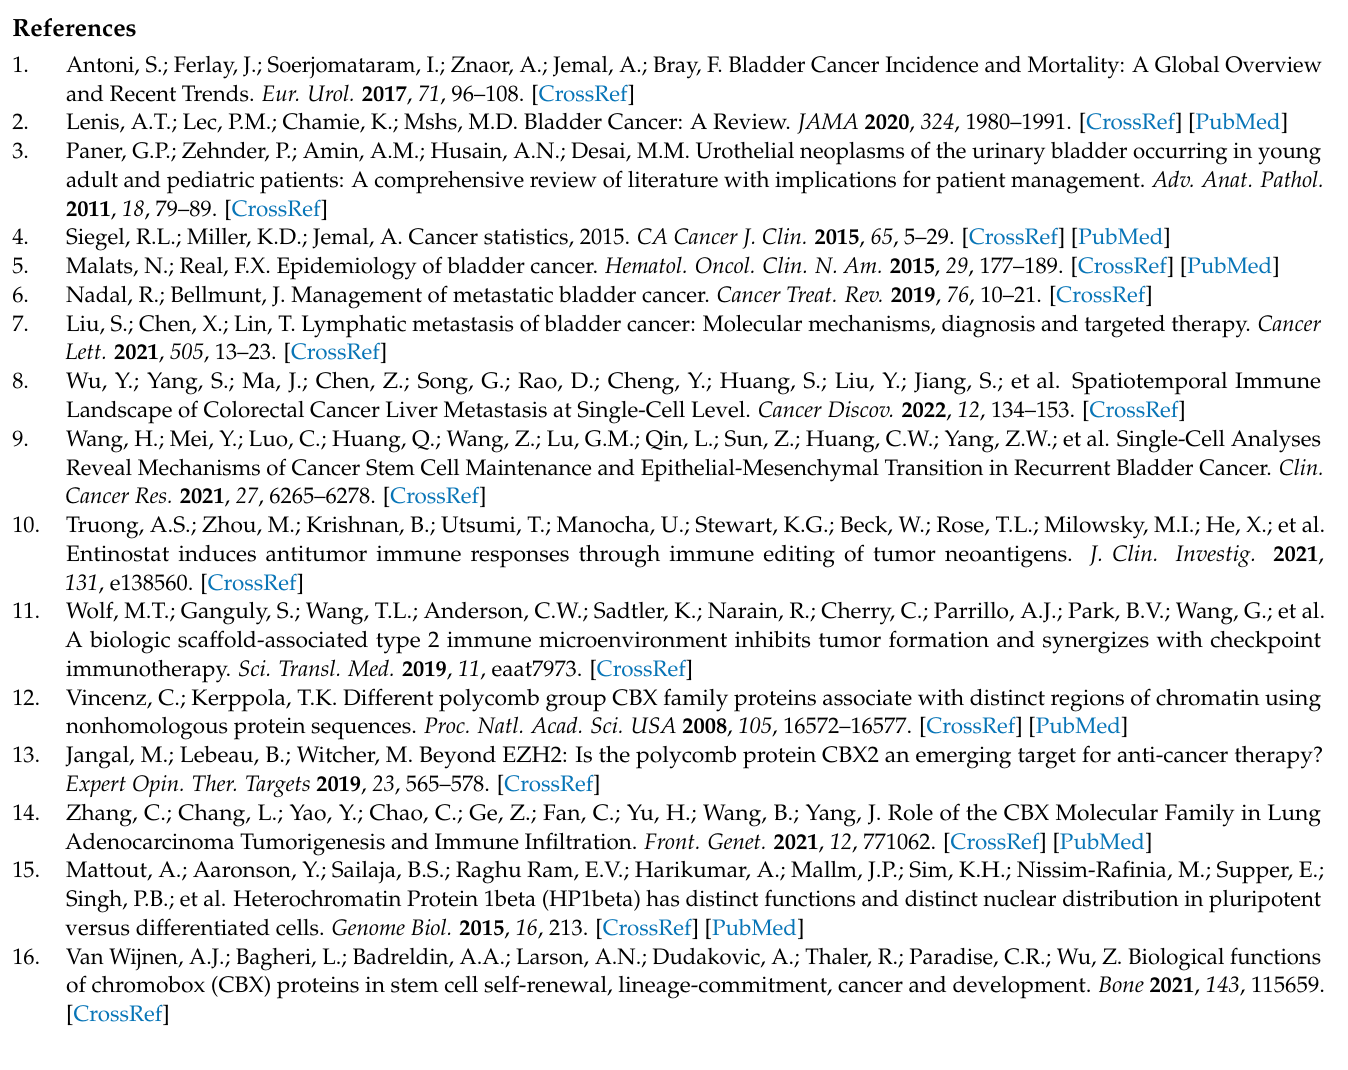
Figure S3: Immunohistochemical of CBXs family members on the Human Protein Atlas